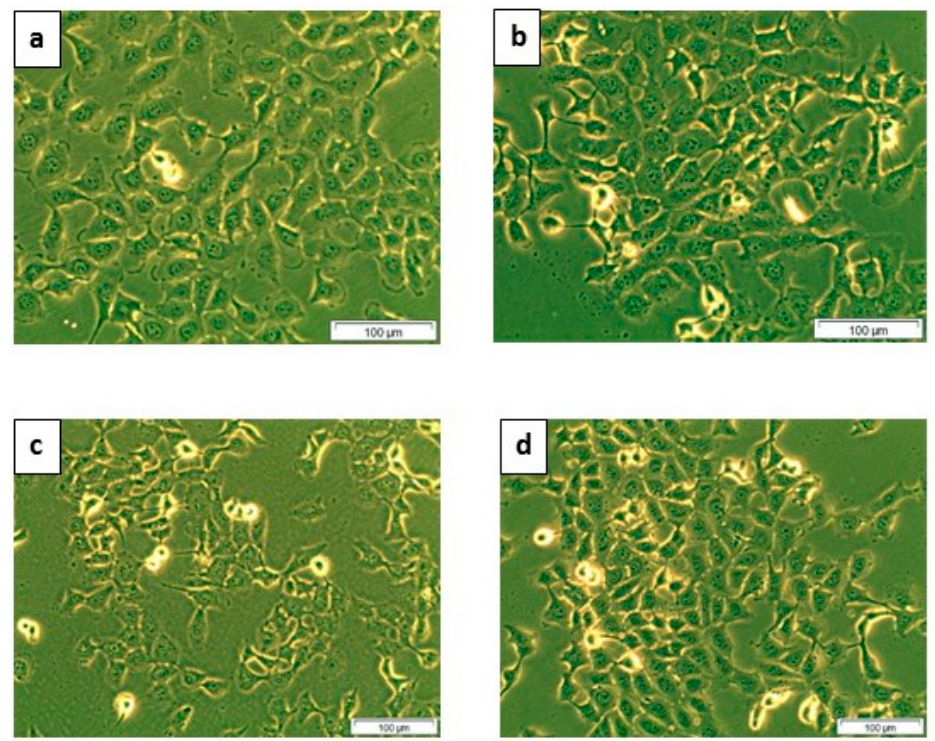
Figure 1. Morphology of MCF-7 cells after Syzygium mundagam bark methanol (SMBM) treatment. The cells in the figure signify the results of toxicity and death induced by SMBM (200× magnification). The cells in the control group ( a ) were seen healthy with an intact membrane and no signs of cell death. The difference in the number of dead rounded cells can be seen in groups treated with 10 ( c ) and 20 µ g ( d ), compared to the control. Sub figure ( b ) represents 5 µ g SMBM extract treated group.